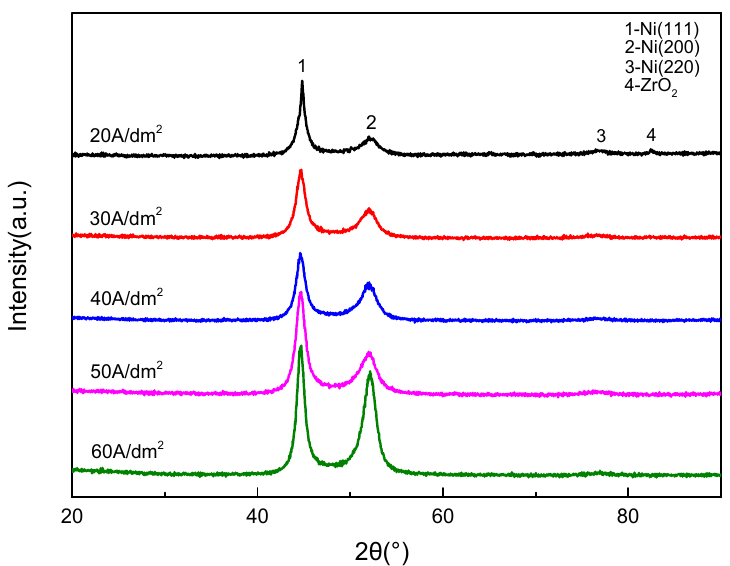
Figure 4. XRD patterns of Ni–P–ZrO 2 –CeO 2 composite coatings prepared at di ff erent current densities. Table 2. Relationship between current density and crystallinity and grain size of Ni (111) crystal surface.